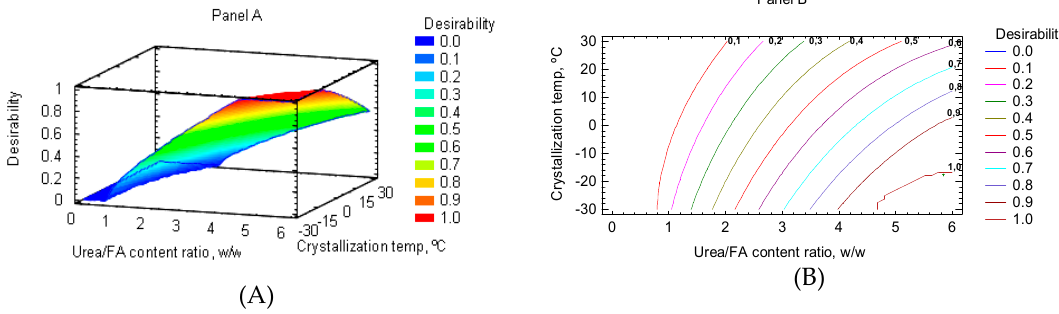
Figure 2. Combination of factors to maximize the desirability function for RCSO concentrate: response surface ( A ) and contour surface ( B ).